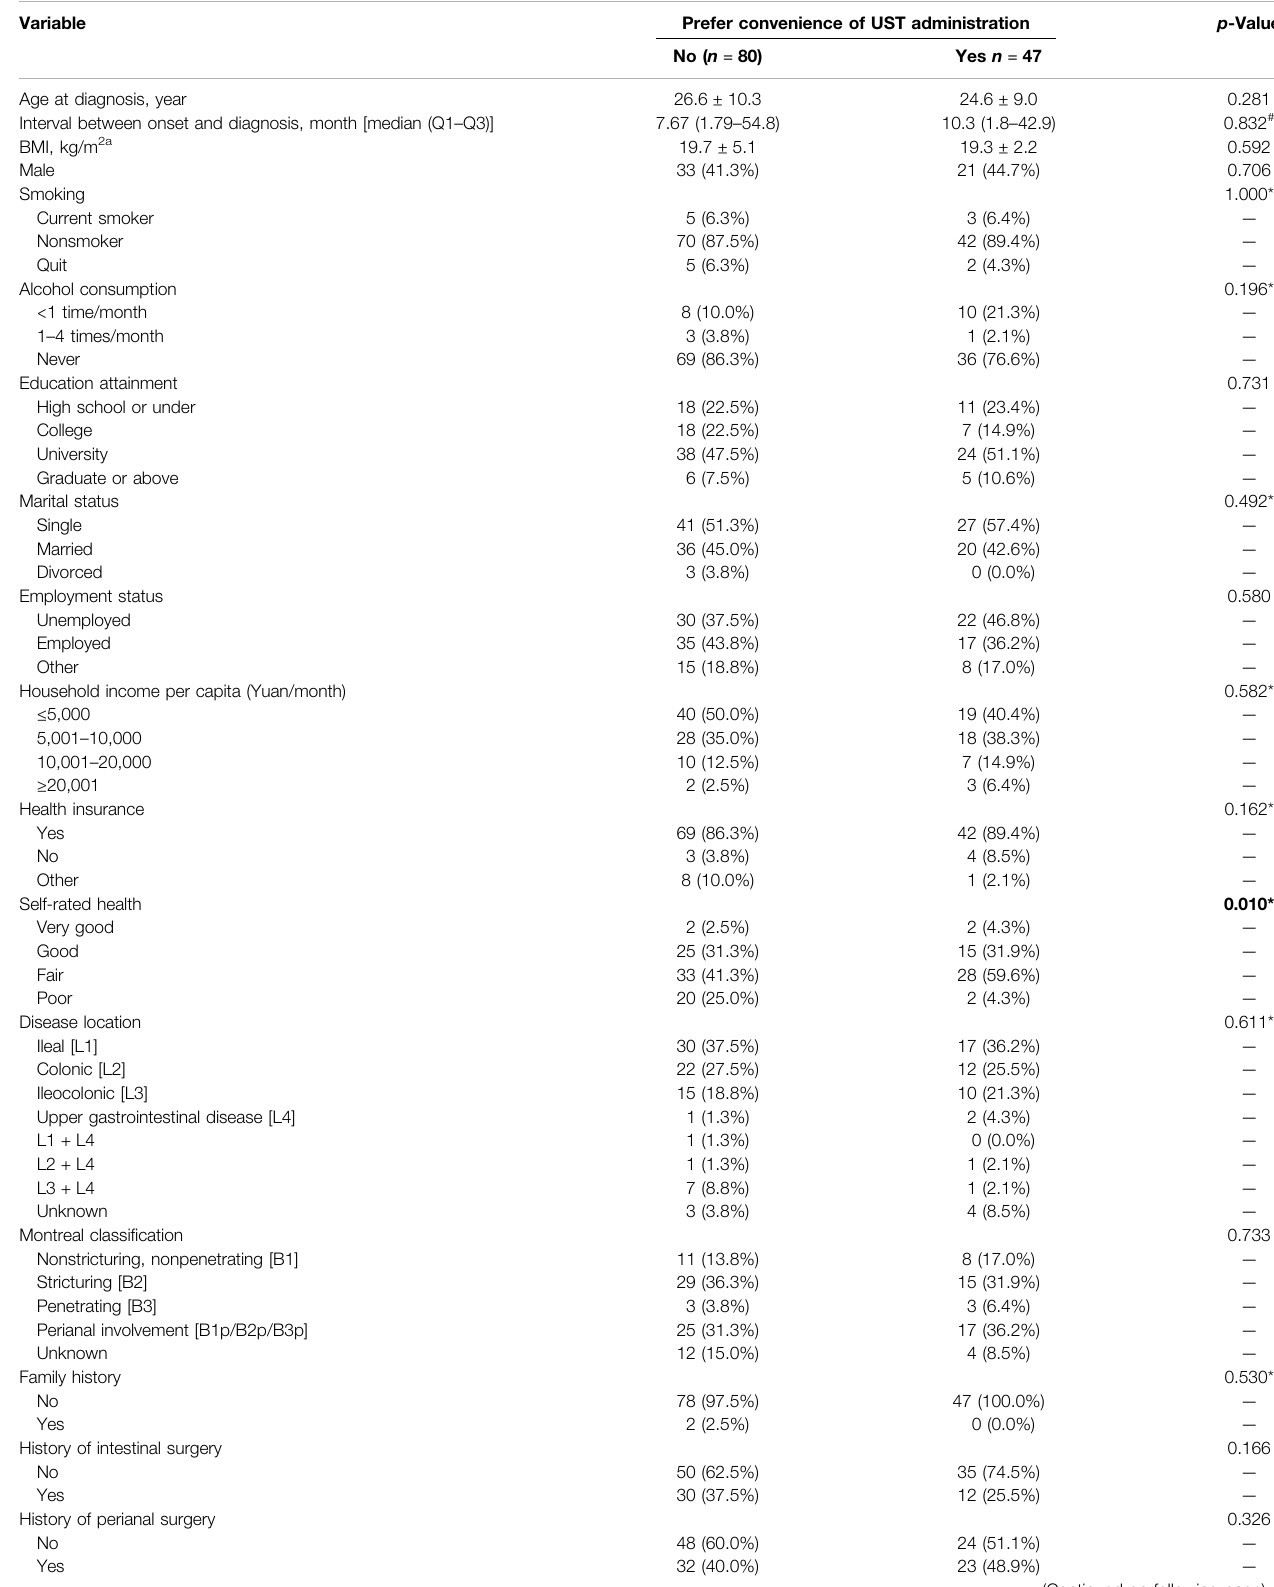
TABLE 6 | Characteristics of participants with different preference toward mode of UST